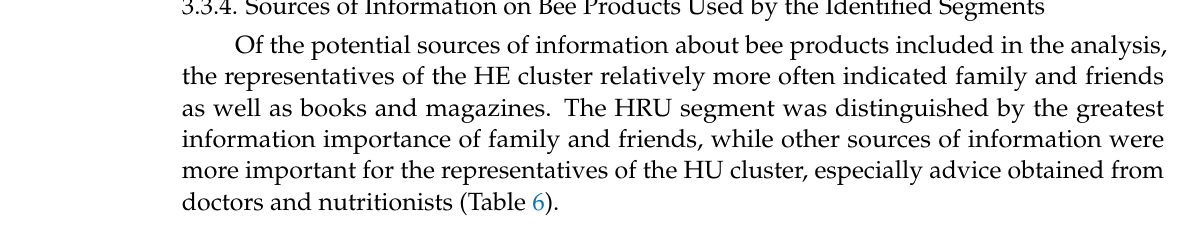
Table 6. Clusters characteristics by sources of information about bee products (n = 487, data in